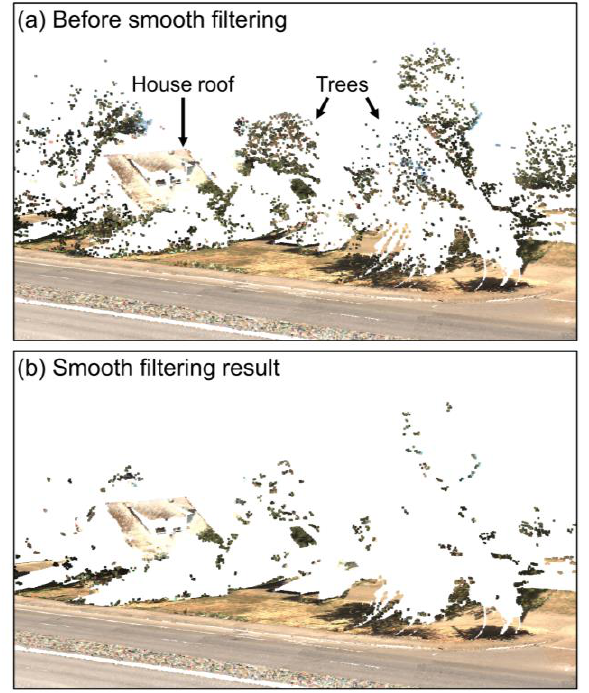
Figure 3 . Example of the proposed local smooth filtering.